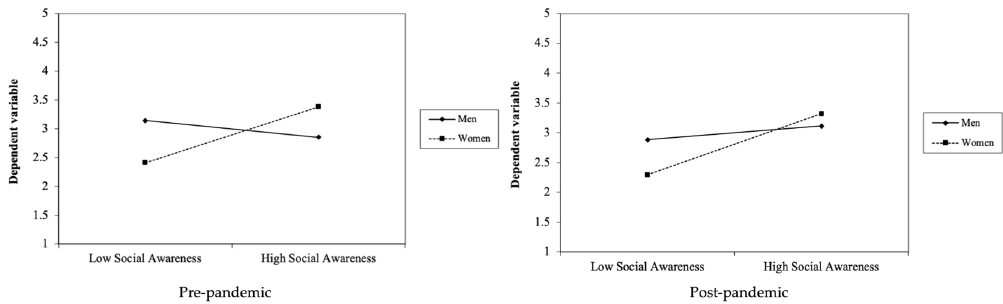
Figure 3. Social awareness moderation effect.